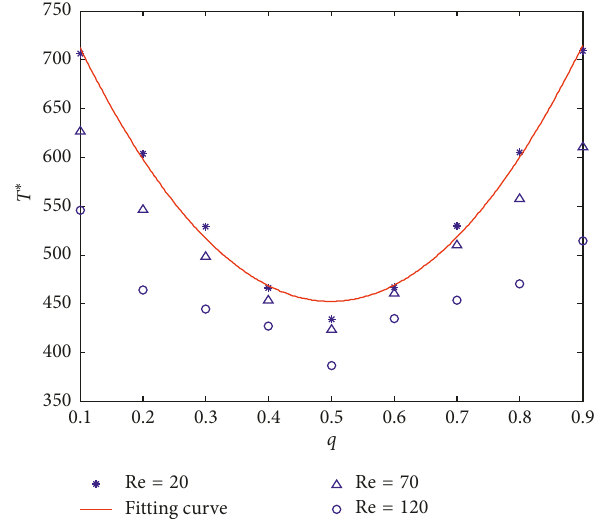
Figure 6: Time needed for the particle to travel in the channel for different values of q